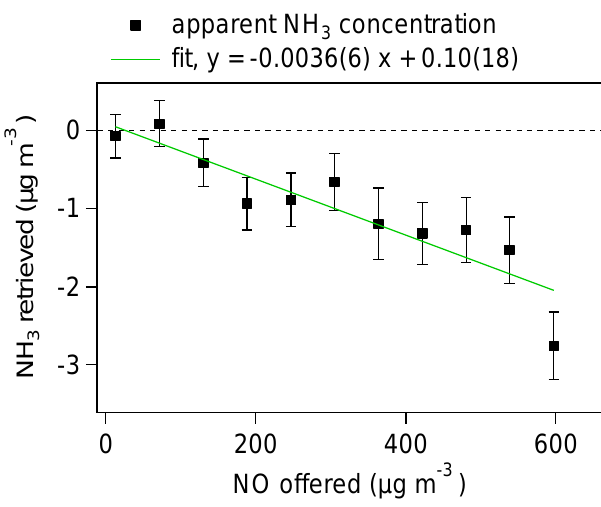
Fig. 10. Results of the NO interference test for the RIVM DOAS instrument.